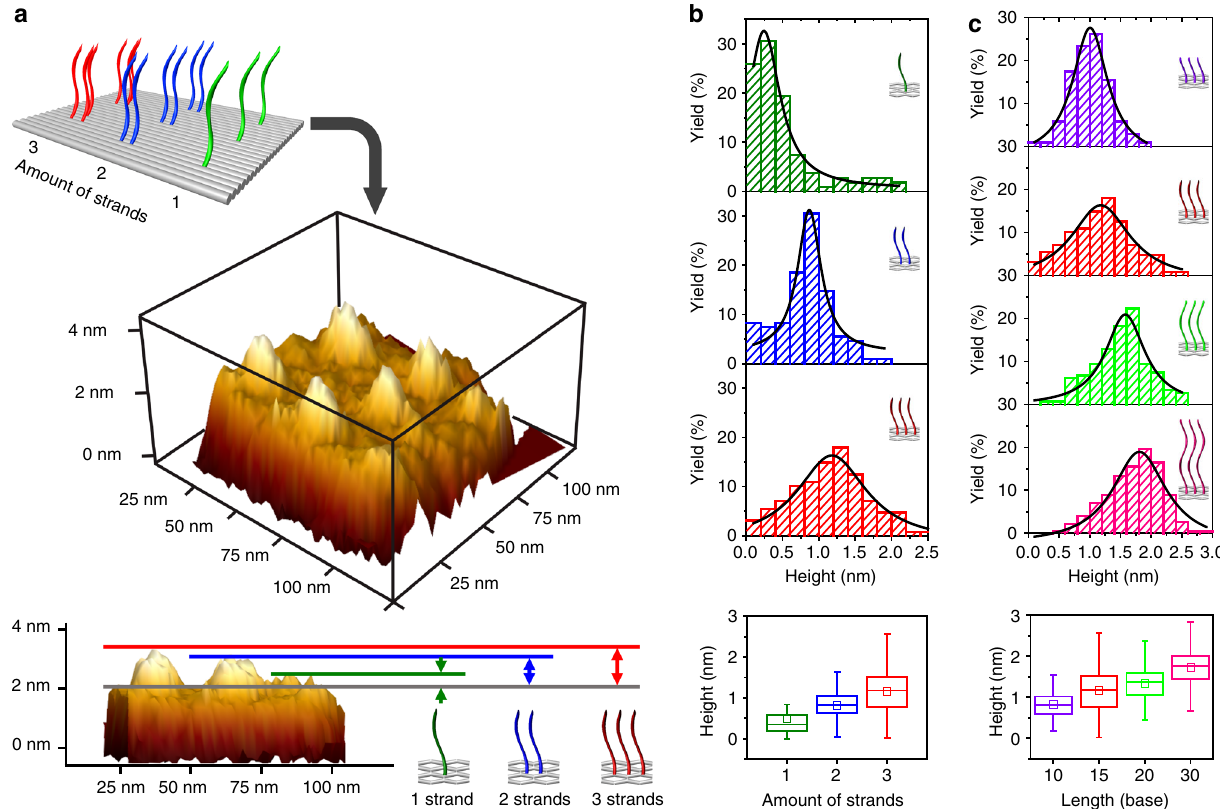
Fig. 2 Number and length effects of pcDNA on DCIMP. a AFM 3D reconstruction (top) and side view (bottom) of a metalized rectangular origami having eight discrete sites with varied numbers of 15-base pcDNA strands. b Distribution of increased height values and statistic analysis of height increase on sites with varied number of strands. The error bars are the standard deviation for N = 108, 108 and 128 samples with different number of strands. c Distribution of increased height values and statistic analysis of height increase on sites with varied length of pcDNA strands. The error bars are the standard deviation for N = 103, 128, 147 and 225 samples with different length of pcDNA